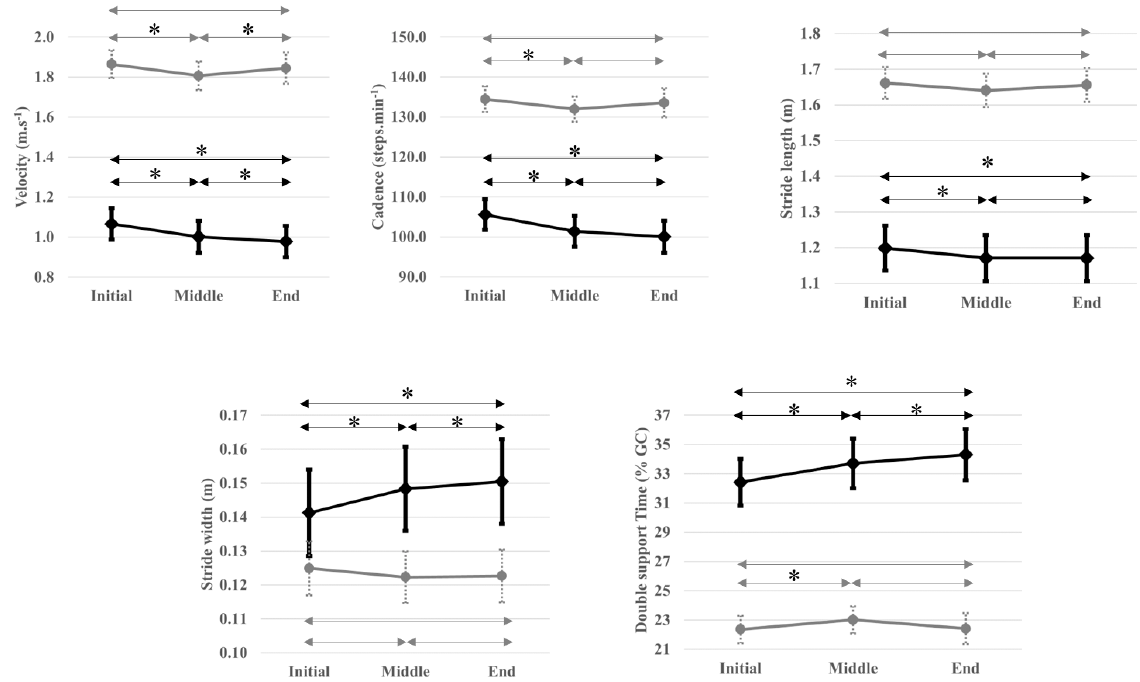
Figure 3. Spatio-temporal variables during each interval of the 6MWT for PwMS (black line) and healthy groups (grey line). GC, gait cycle. * Significant differences between intervals in each group (e.g., PwMS and healthy people) with p < 0.025.